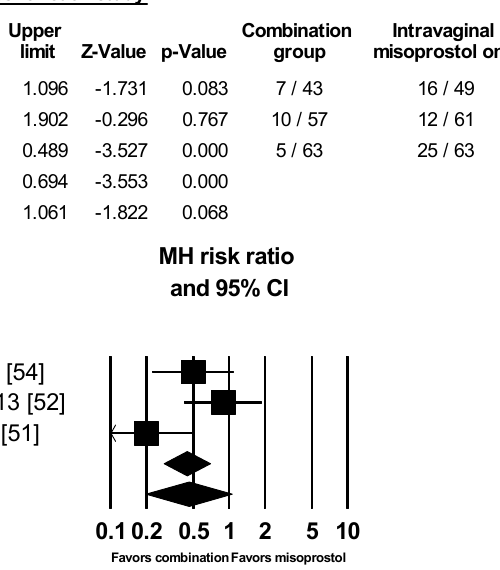
Figure 7. Comparison 6: Combination of intracervical Foley catheter and intravaginal misoprostol versus intravaginal misoprostol alone for cervical ripening, Outcome 6: Tachysystole with fetal heartbeat change. Heterogeneity: Tau 2 = 0.377; χ 2 = 6.406 df = 2 ( p = 0.041); I 2 = 68.778%. Test for overall effect (random): Z= − 1.822 ( p = 0.068).